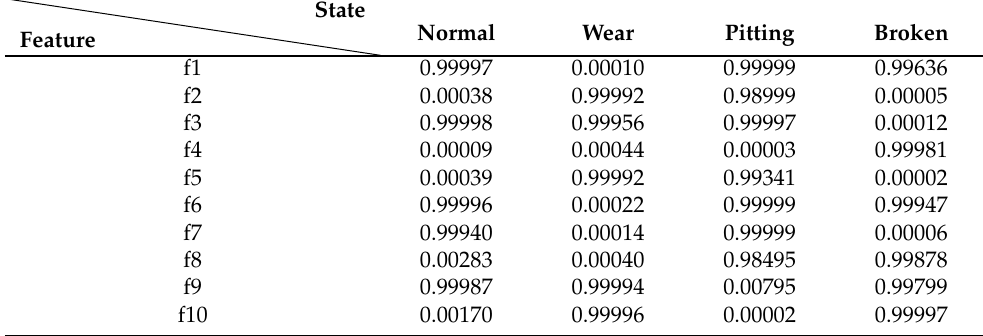
Table 5. Eigenvalues from 1DCNN.